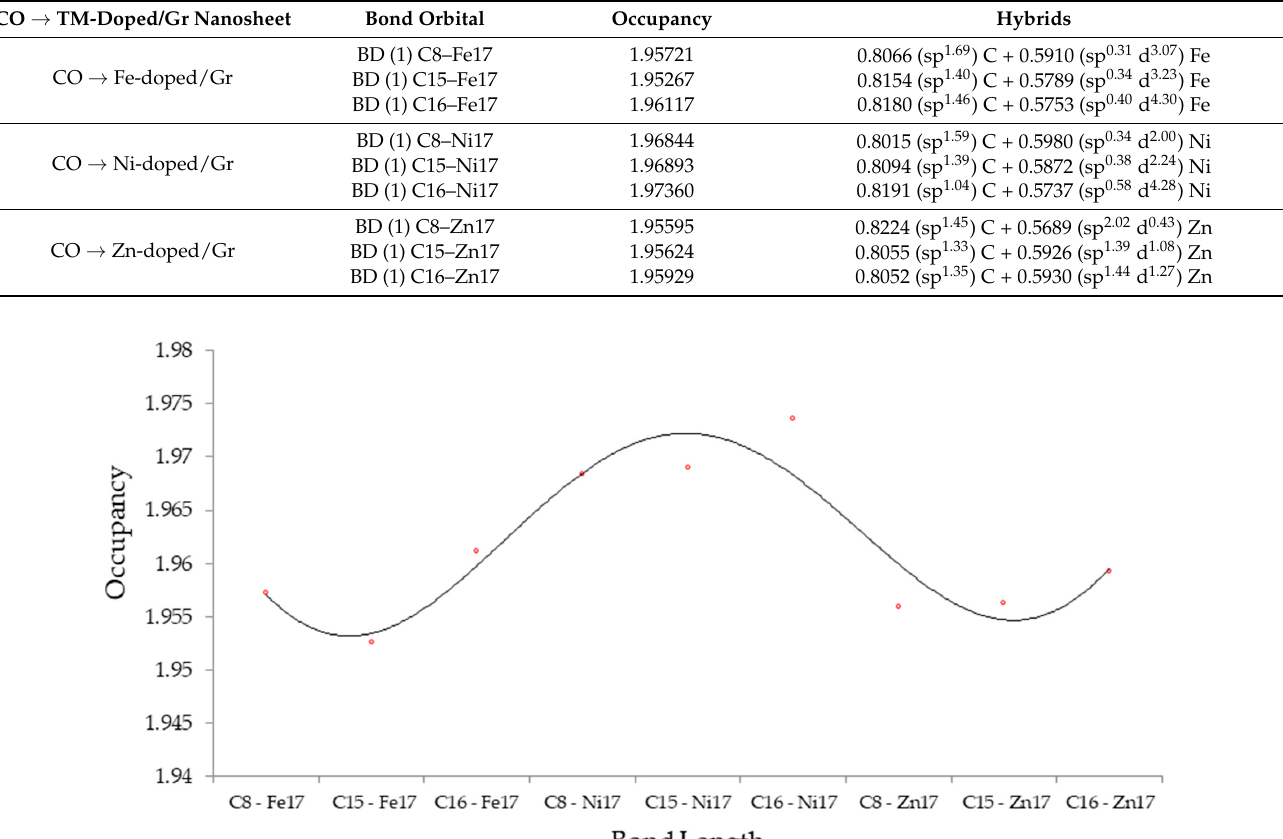
Table 2. NBO analysis for CO on the TM (Fe, Ni, Zn)-doped/Gr nanosheets.